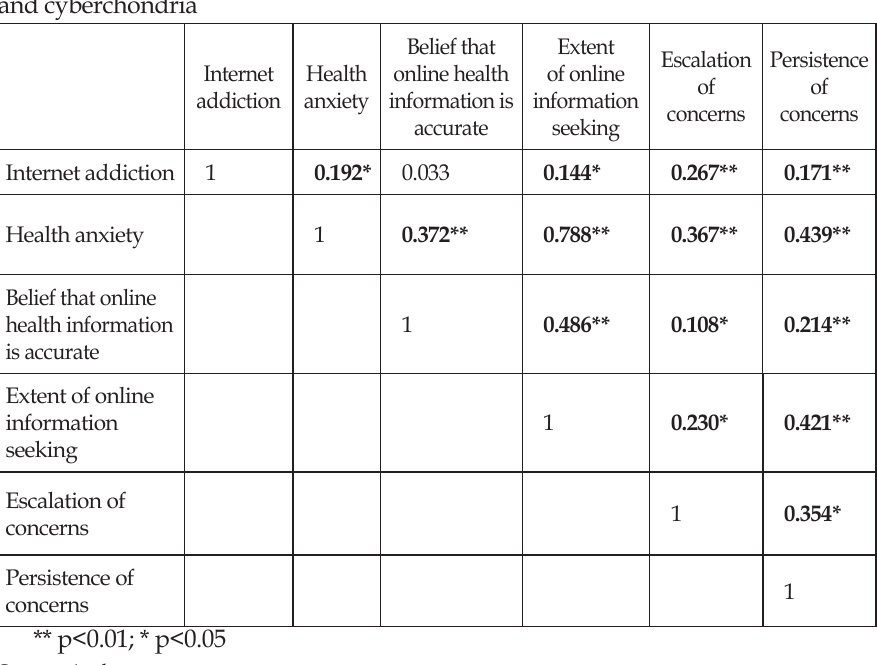
Table 2. Results from correlation analyses of Internet addiction, health anxiety and cyberchondria